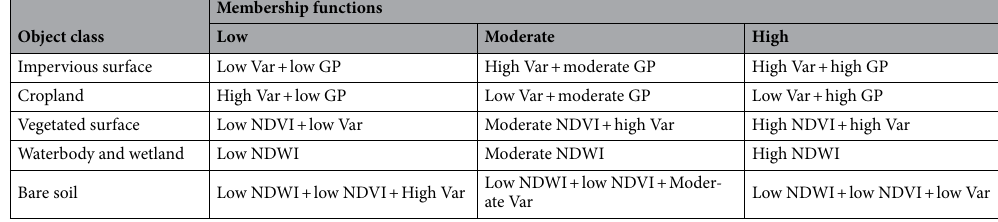
Table 1. Proposed fuzzy rules for the determination of each object class by having Var, GP, NDVI, and